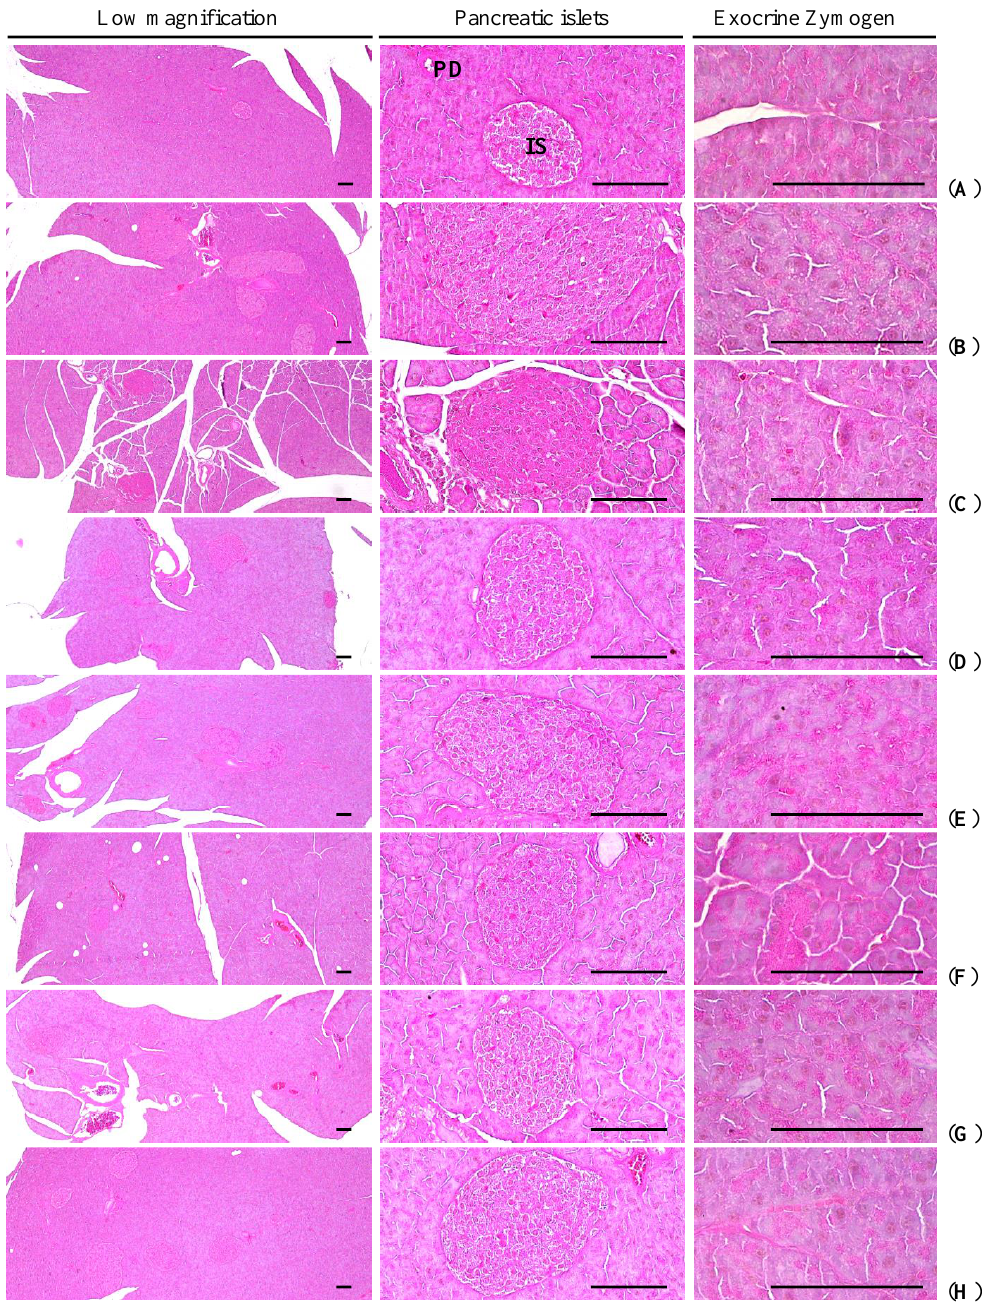
Figure 4. Representative general histological images of the pancreas, taken from NFD or HFD supplied mice. ( A ) Intact control: Normal pellet diet supplied vehicle control mice; 10 mL/kg of distilled water oral administered mice; ( B ) HFD (vehicle) control: 10 mL/kg of distilled water oral administered mice with HFD supply; ( C ) Simvastatin: 10 mg/kg of simvastatin oral administered mice with HFD supply; ( D ) Metformin: 250 mg/kg of metformin oral administered mice with HFD supply; ( E ) GT400: 400 mg/kg of GT oral administered mice with HFD supply; ( F ) fGT400: 400 mg/kg of fGT oral administered mice with HFD supply; ( G ) fGT200: 200 mg/kg of fGT oral administered mice with HFD supply; ( H ) fGT100: 100 mg/kg of fGT oral administered mice with HFD supply. NFD, normal fat pellet diet; HFD, high fat diet; GT, green tea extracts; fGT, Aquilariae lignum -fermented green tea extracts; IS, pancreatic islet; PD, pancreatic secretory duct. All Hematoxylin & Eosin stain. Scale bars = 80 µm.